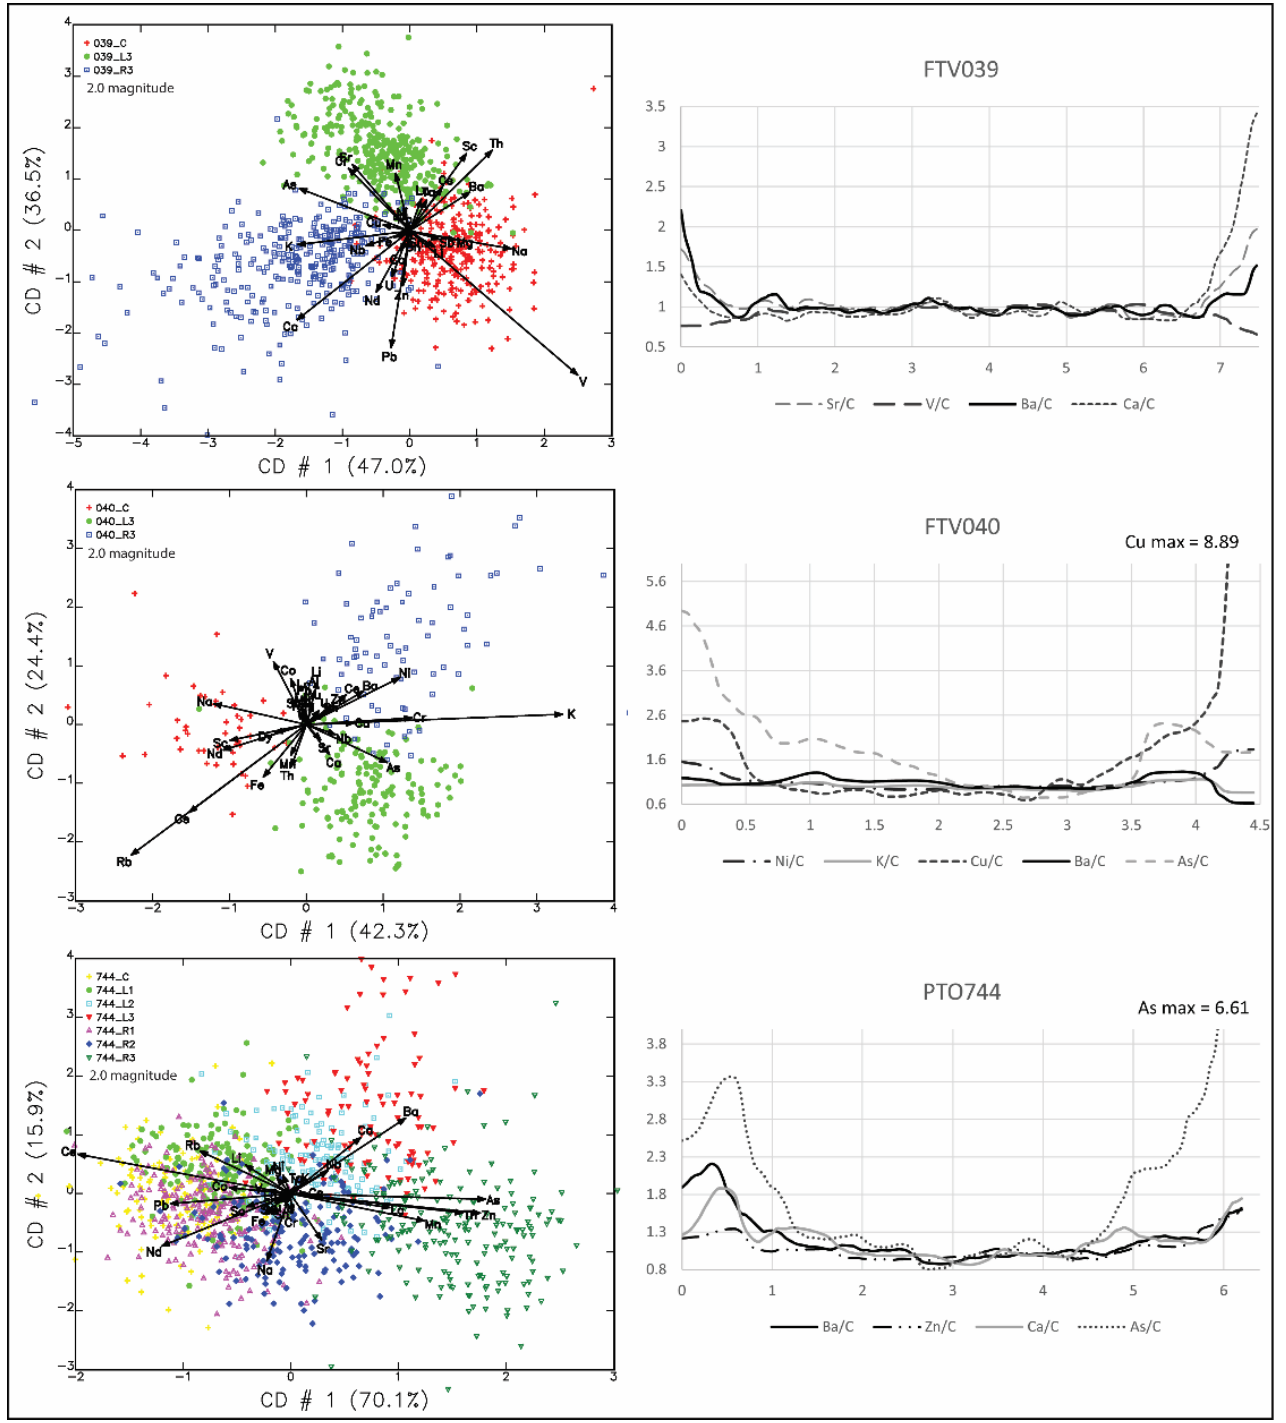
Figure 8. Group A1 and T1 ceramics. ( Left ) Canonical discriminant analysis of trimmed data points coded by zone (zones that do not diverge from the core not shown). ( Right ) Profiles of trimmed and smoothed data for elements that show significant zonal patterning. The x-axis is the position in the cross-section of the sherd in mm; the y-axis is the concentration of elements (in μg/g) expressed as a ratio to the average core concentration for the same element.